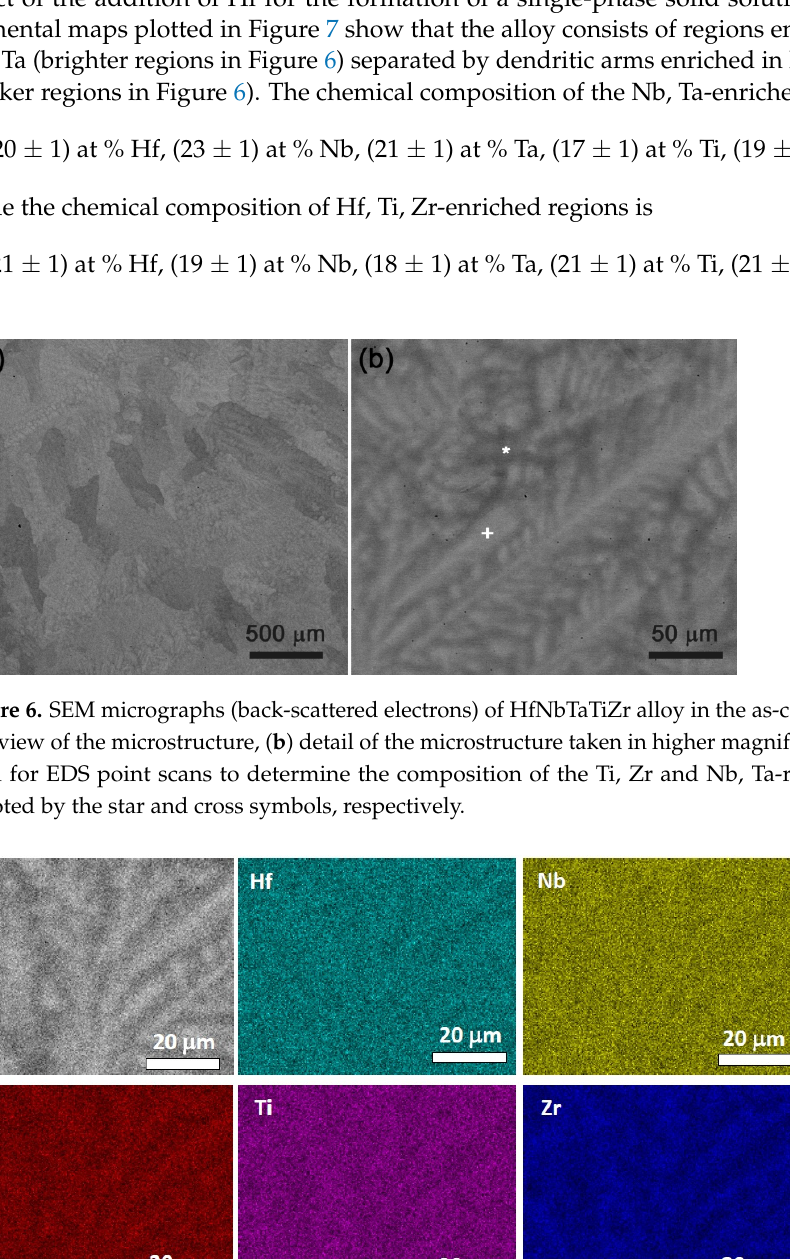
Figure 8. XRD pattern of HfNbTaTiZr alloy in the as-cast state and after annealing at 1200 °C. The label β denotes reflection arising from the Cu K β wavelength. The microstructure of HfNbTaTiZr alloy annealed at 1200 °C is plotted in Figure 9. Annealing obviously resulted in the formation of a single-phase solid solution. The EDS